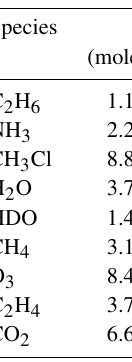
Table 3. Overview of SFIT4 a priori